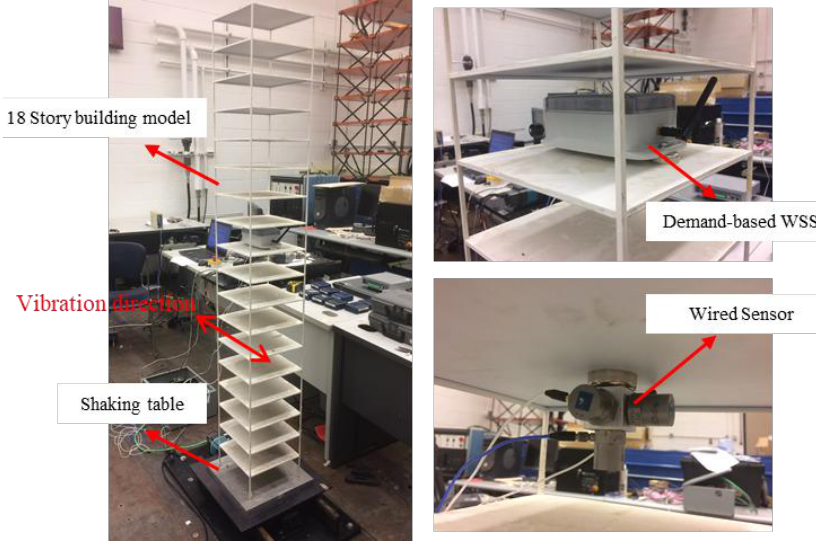
Figure 6. Experiment setup for a demand-based WSS.